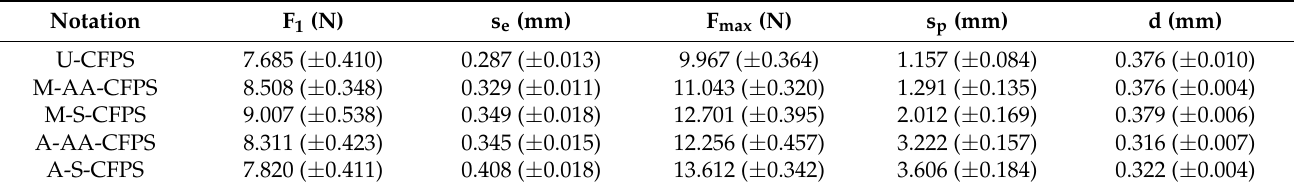
Figure 8. Single-fiber pullout test results for untreated and combined method treated coir fiber pullout specimens: ( a ) Load–displacement curves, ( b ) The calculated interfacial shear strength and pullout energy. Table 4. Key data for calculating interfacial shear strength and pullout energy of untreated and combined method treated coir fiber pullout